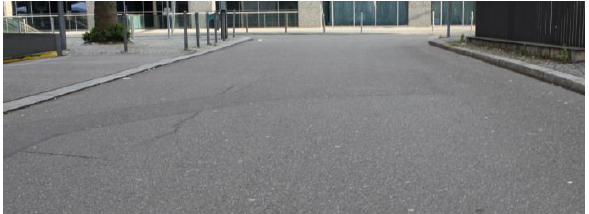
Figure 1. A example of a low curb on the left side of the imaged